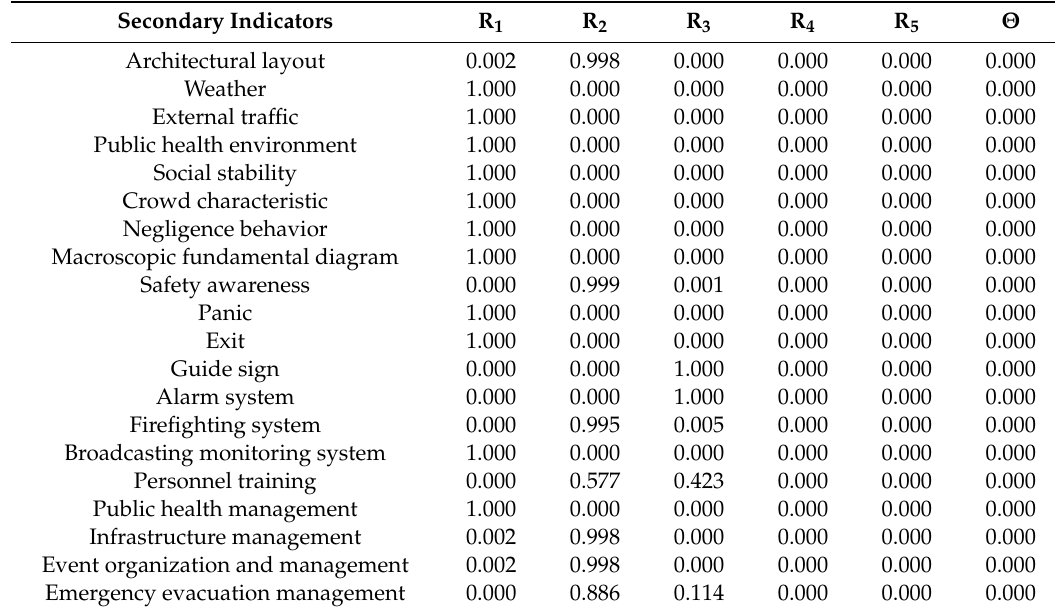
Table 5. Results of Mass function of secondary indicators.